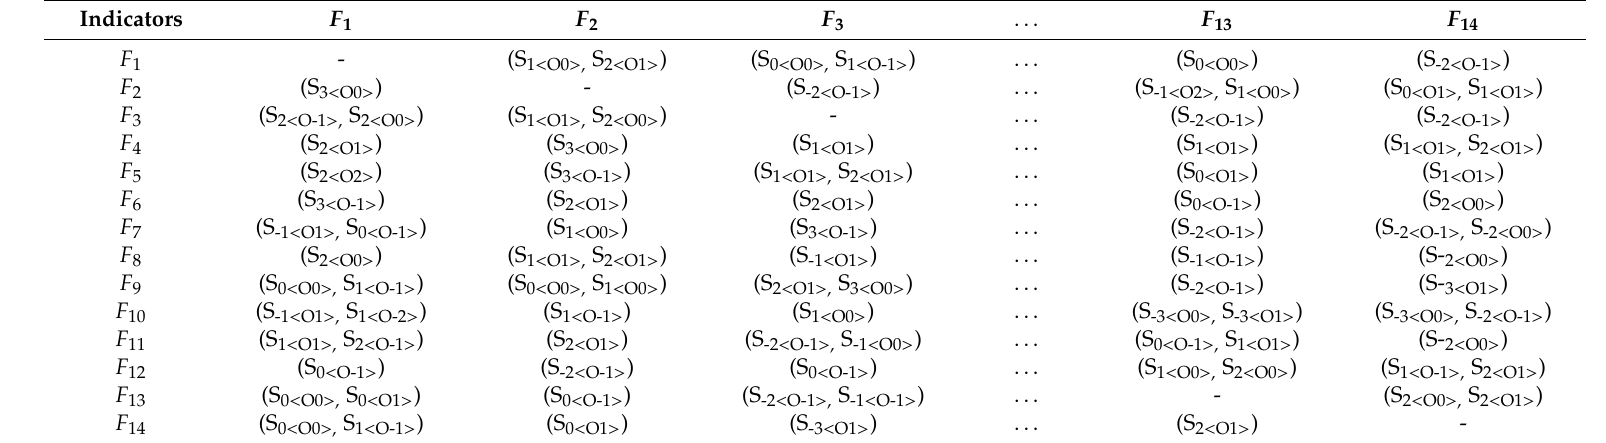
Table 2. Hesitant linguistic evaluation matrix of the first expert.